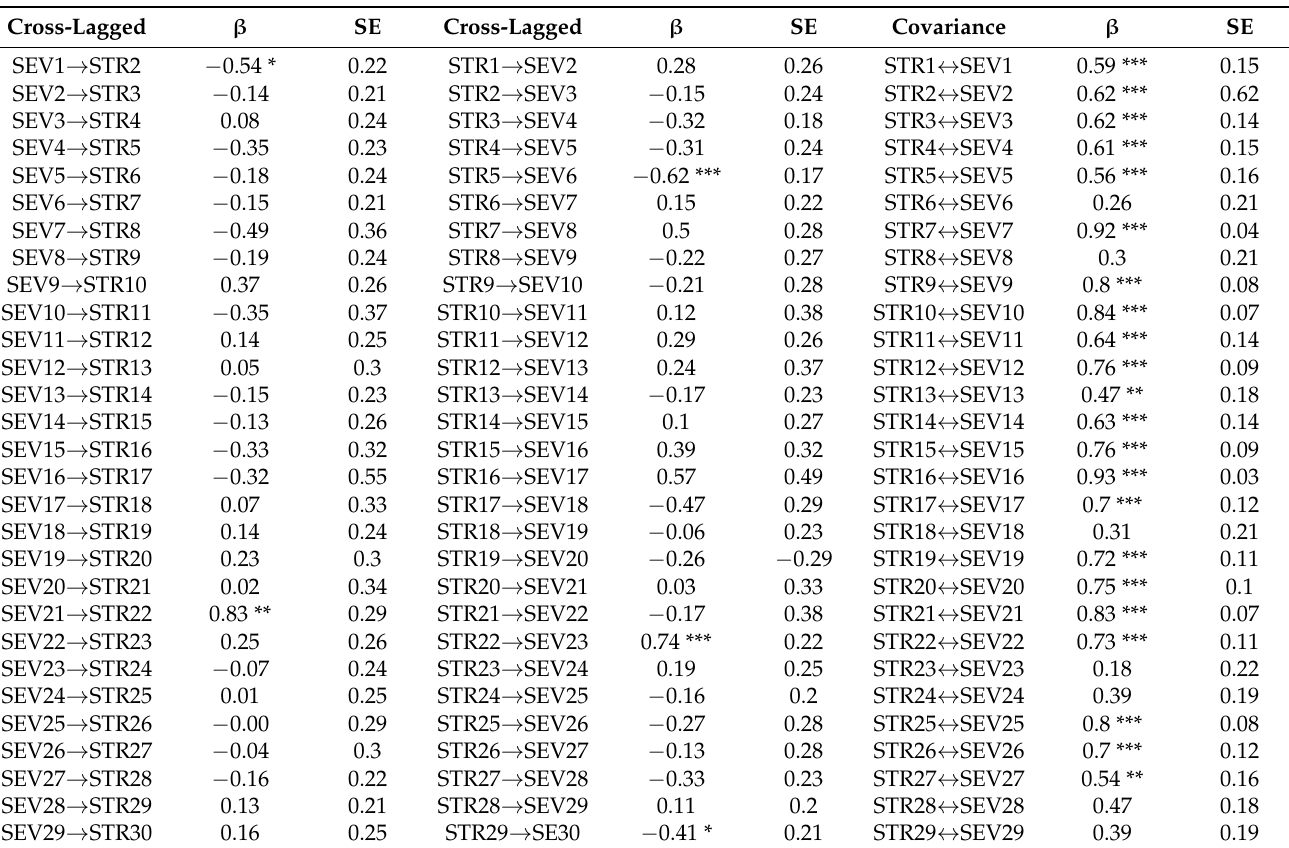
Table 3. Standardized parameter estimates for random-intercept cross-lagged panel models on stress (STR) and AD severity (SEV) ( n =